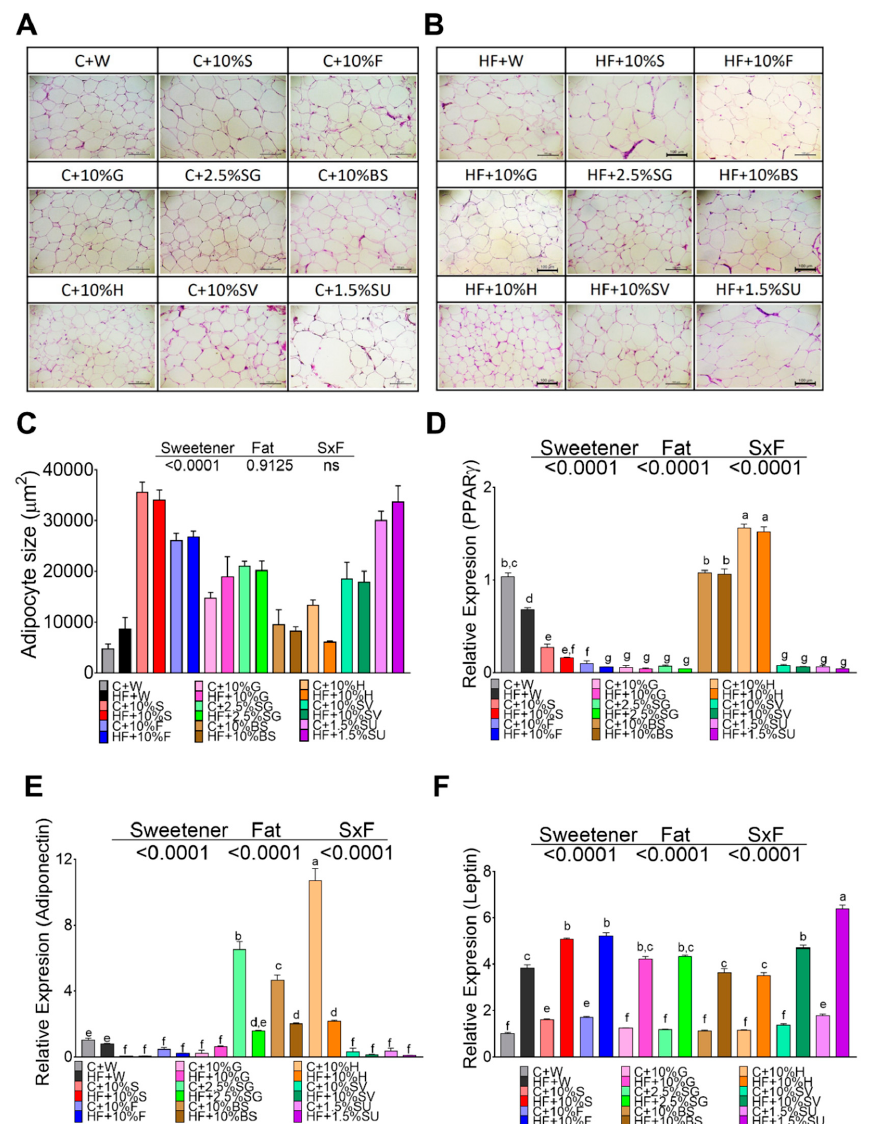
Figure 4. The type of sweetener and high fat diet differentially modify the functionality of the adipocyte in white adipose tissue. Hematoxylin-Eosin staining (HE) of white adipose tissue of rats fed different sweeteners with control ( A ) or high fat diet ( B ); adipocyte size ( C ); mRNA relative expression of peroxisome proliferator-activated receptor gamma (PPAR γ ) ( D ), adiponectin ( E ) and leptin ( F ). The data are expressed as the mean ± SEM ( n = 6). Results were considered statistically significant at p < 0.05. Significant differences among groups are indicated by letters, where a > b > c > d > e. 3.6. Sweeteeners Differentially Regulate Gene Expression of Adiponectin and UCP-1 in BAT. The size of the brown adipocytes in control rats without sweetener was around 124 μ m 2 . Animals fed with sucrose (720 μ m 2 ), sucralose (630 μ m 2 ), or fructose (630 μ m 2 ) showed the biggest brown